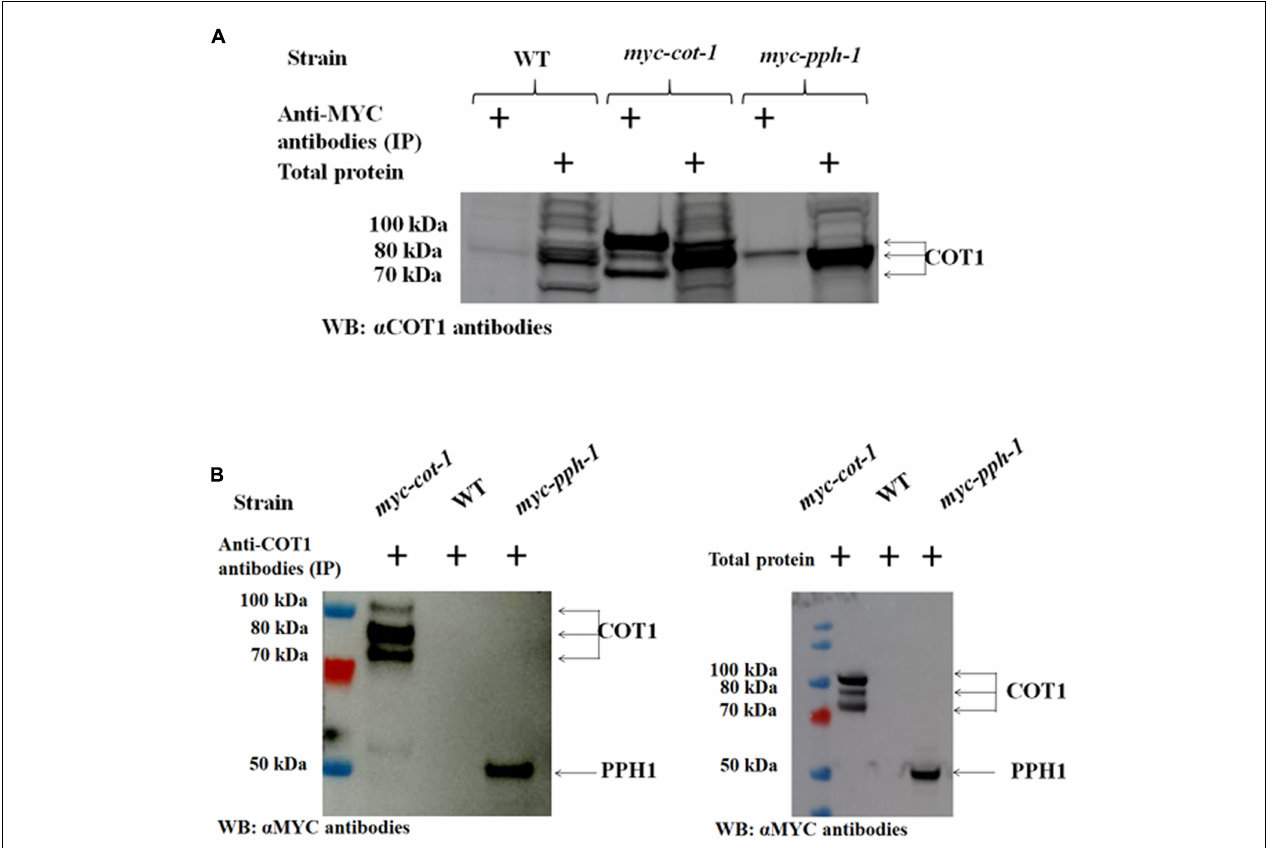
FIGURE 10 | The PP2A catalytic subunit PPH1 physically interacts with COT1. (A) Detection of COT1 in total protein extracts and those immunoprecipitated with anti-MYC antibodies. All were probed with anti-COT1 antibodies. Arrows indicate the detected COT1 forms. (B) Detection of MYC::PPH1 in protein extracts immunoprecipitated with anti-COT1 antibodies and probed with anti-MYC antibodies (left panel) and in total protein extracts (right panel). Arrows indicate COT1 forms and MYC-tagged